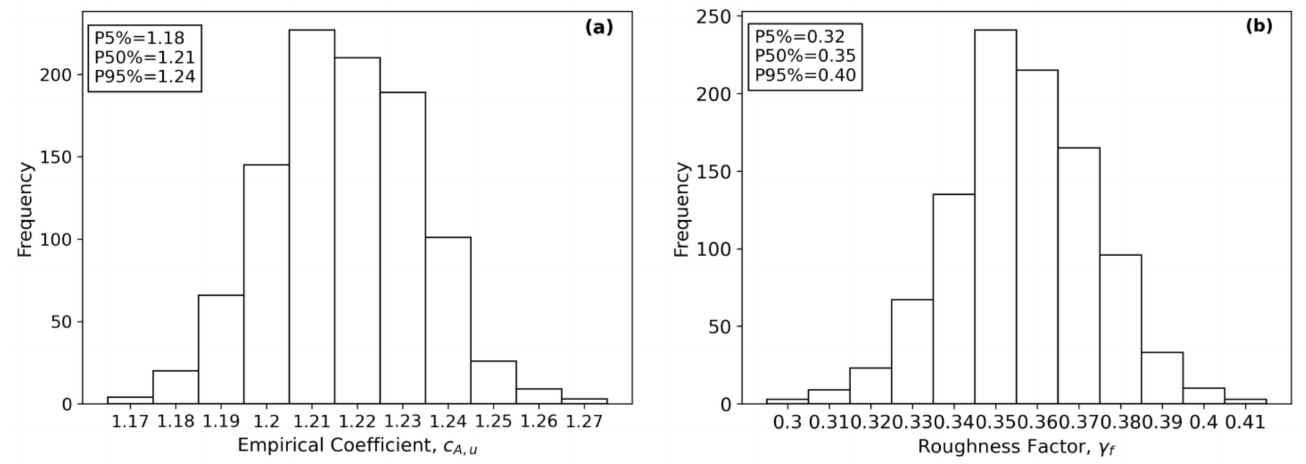
Figure 8. Histogram plot of the empirical coefficient, c A , u , and the roughness factor, γ f , obtained from the bootstrap resampling: ( a ) the first level bootstrap and ( b ) the second level bootstrap.